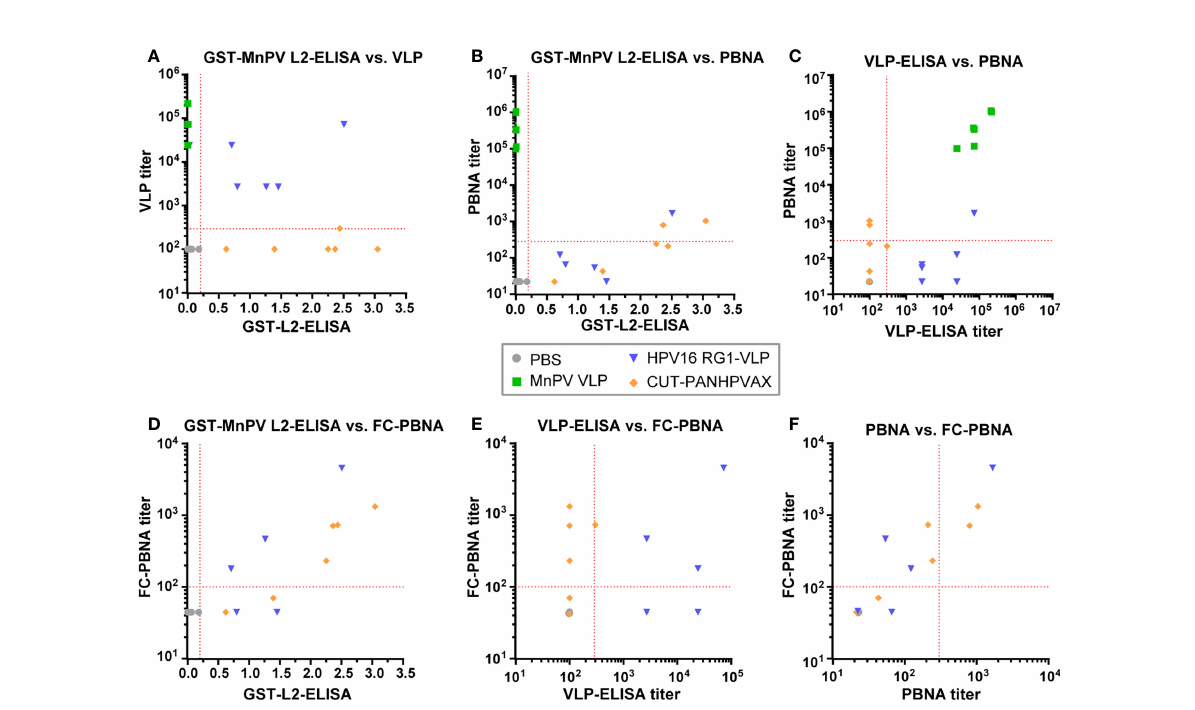
FIGURE 3 Correlation between GST-MnPV L2-ELISA, VLP-ELISA and PBNA data. Data at week 10 obtained from (A) GST-MnPV L2-ELISA and MnPV VLP- ELISA; (B) GST-MnPV L2-ELISA and MnPV PBNA; (C) MnPV VLP-ELISA and MnPV PBNA; (D) GST-MnPV L2-ELISA and FC-PBNA; (E) MnPV VLP- ELISA and FC-PBNA; (F) MnPV PBNA and FC-PBNA. Animals were vaccinated with MnPV VLPs (green squares), HPV16 RG1-VLPs (blue triangles), CUT-PANHPVAX (orange rhombi) or PBS (grey dots). All groups consist of n=6 animals. Dashed lines represent the methods ’ cut-off (OD 450 = 0.2 for GST-ELISA or titer of 300 for MnPV VLP-ELISA and MnPV PBNA or titer of 100 for MnPV FC-PBNA) (Note that sera of the MnPV VLP group were not measured in MnPV FC-PBNA due to limited amount of